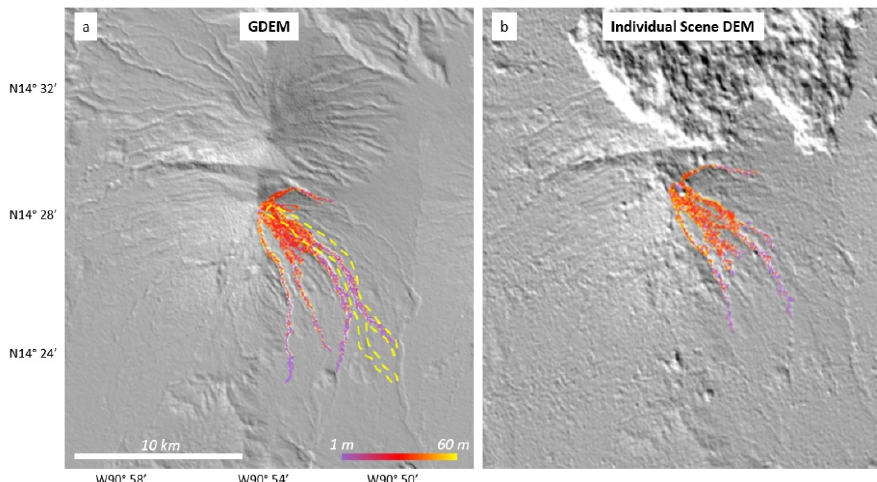
Figure 6. VolcFlow model result of PDC coverage for an eruptive volume of 30 × 10 6 m 3 shown over: ( a ) the ASTER global digital elevation model (GDEM) version 2 product and ( b ) an individual ASTER scene DEM from 24 January 2018. Warmer colors indicate thicker PDC coverage estimated by the model. The dashed yellow outline in ( a ) is the approximate coverage area of the 3 June 2018, pyroclastic flow. Increased noise in ( b ) cause artificial topographic barriers that produced inaccurate model results and much shorter PDC flows.